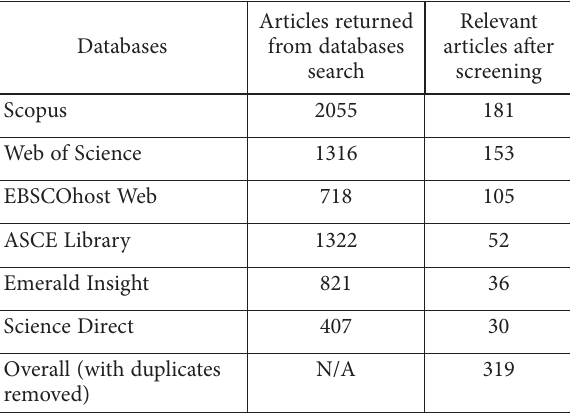
Table 1. Number of articles returned from online databases